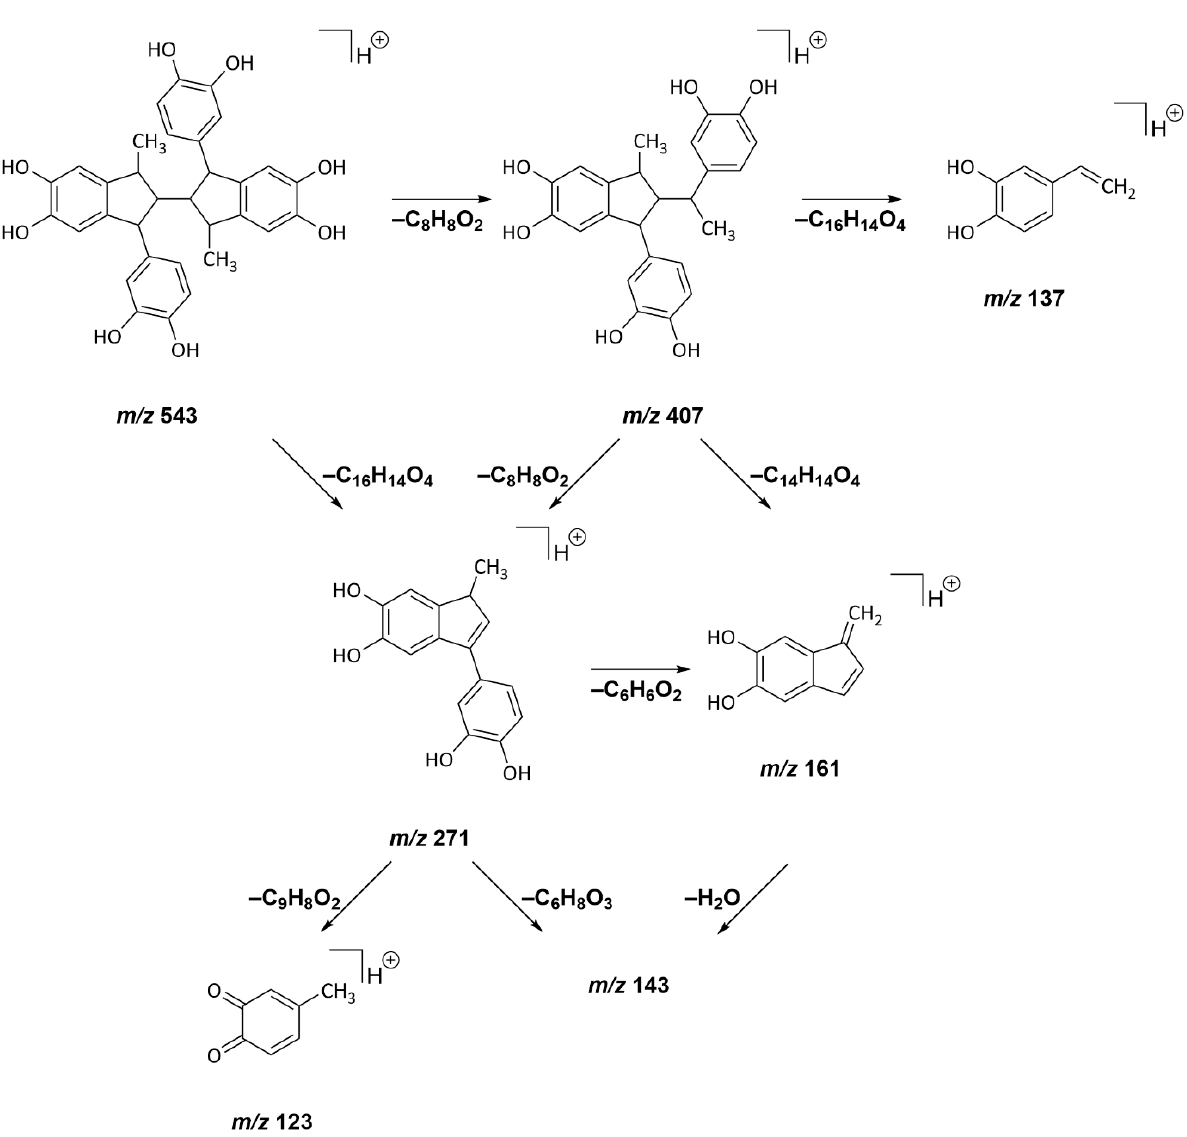
Figure 5. Fragmentation pathways for the pseudomolecular ion m/z 543, as analyzed by means of APCI(+)-HRMS n experiments.